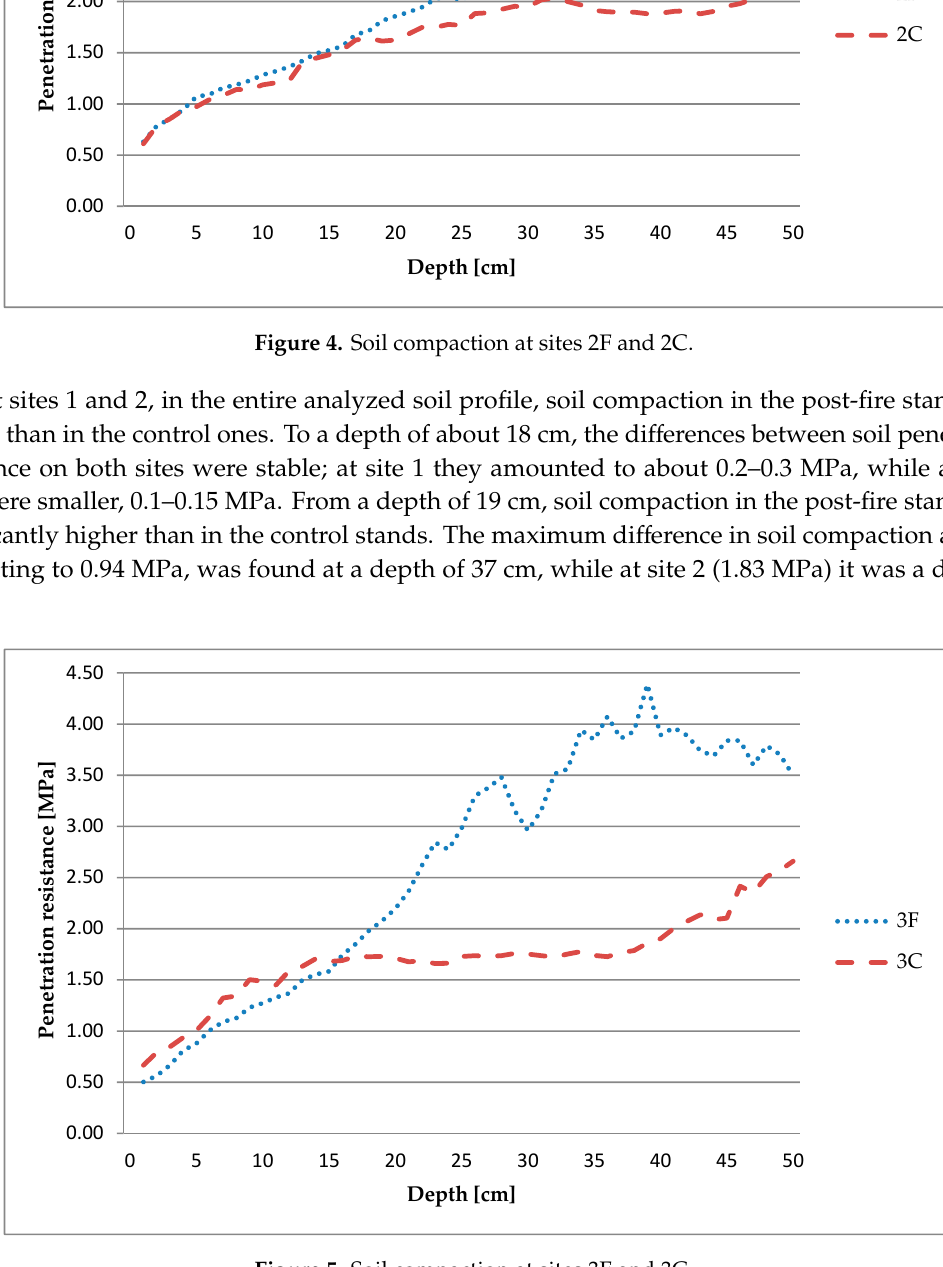
Figure 5. Soil compaction at sites 3F and 3C.